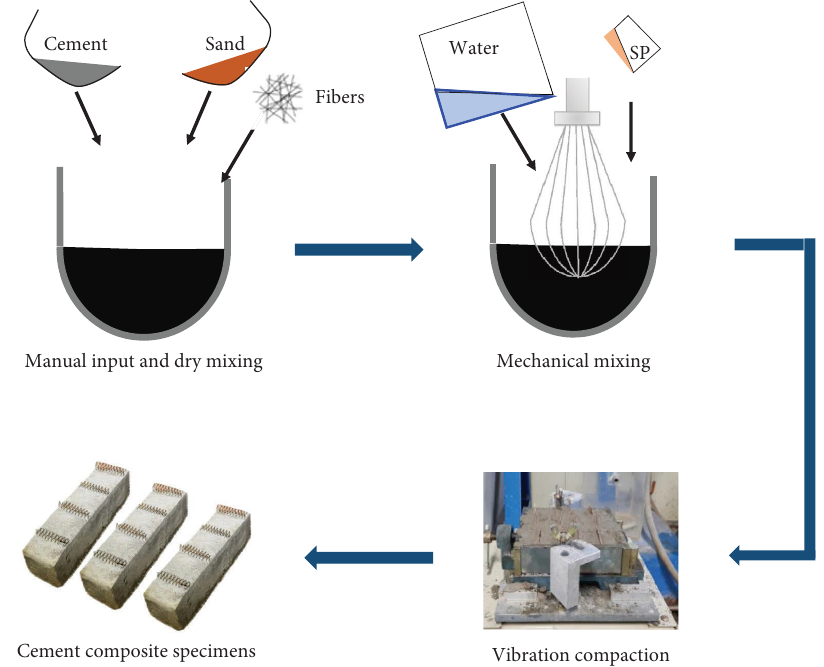
Figure 3: Te fabrication process of cement